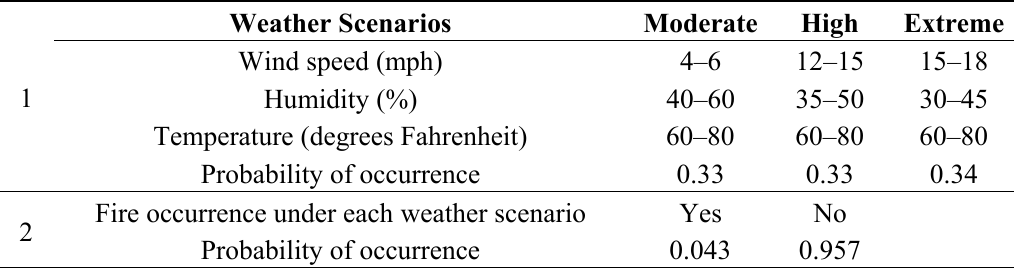
Table 3. SIP model scenario data.